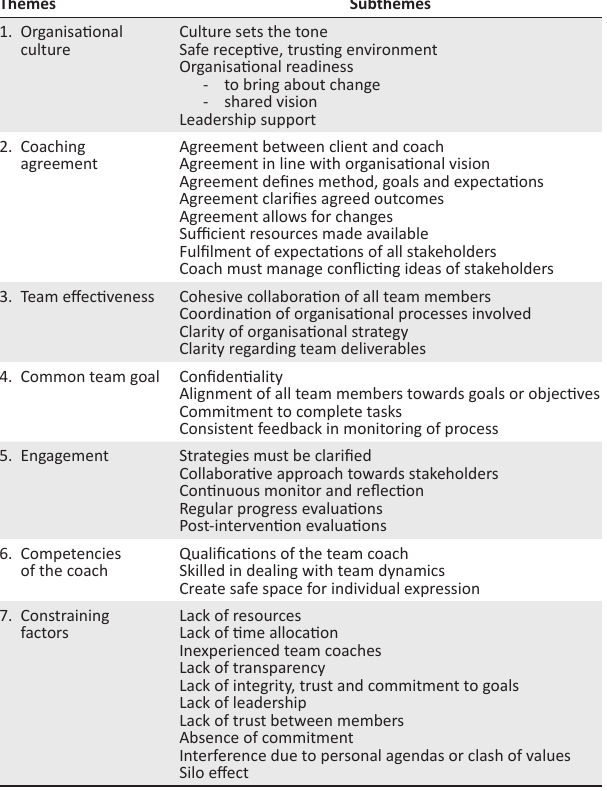
TABLE 1: Main themes that support team coaching (current authors)